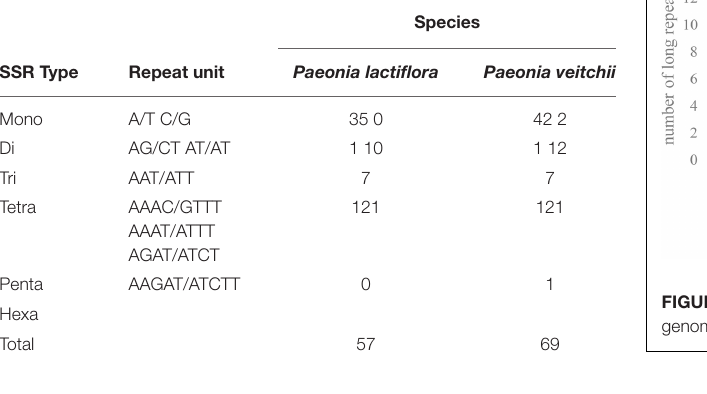
TABLE 1 | Types and numbers of SSRs in the chloroplast genomes of Paeonia lactiflora and Paeonia veitchii.